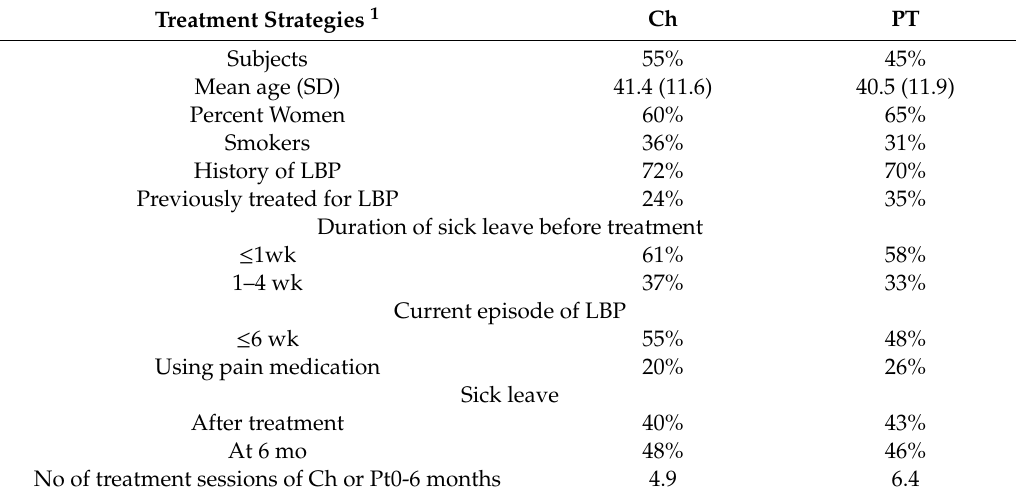
Table 1. Baseline characteristics of